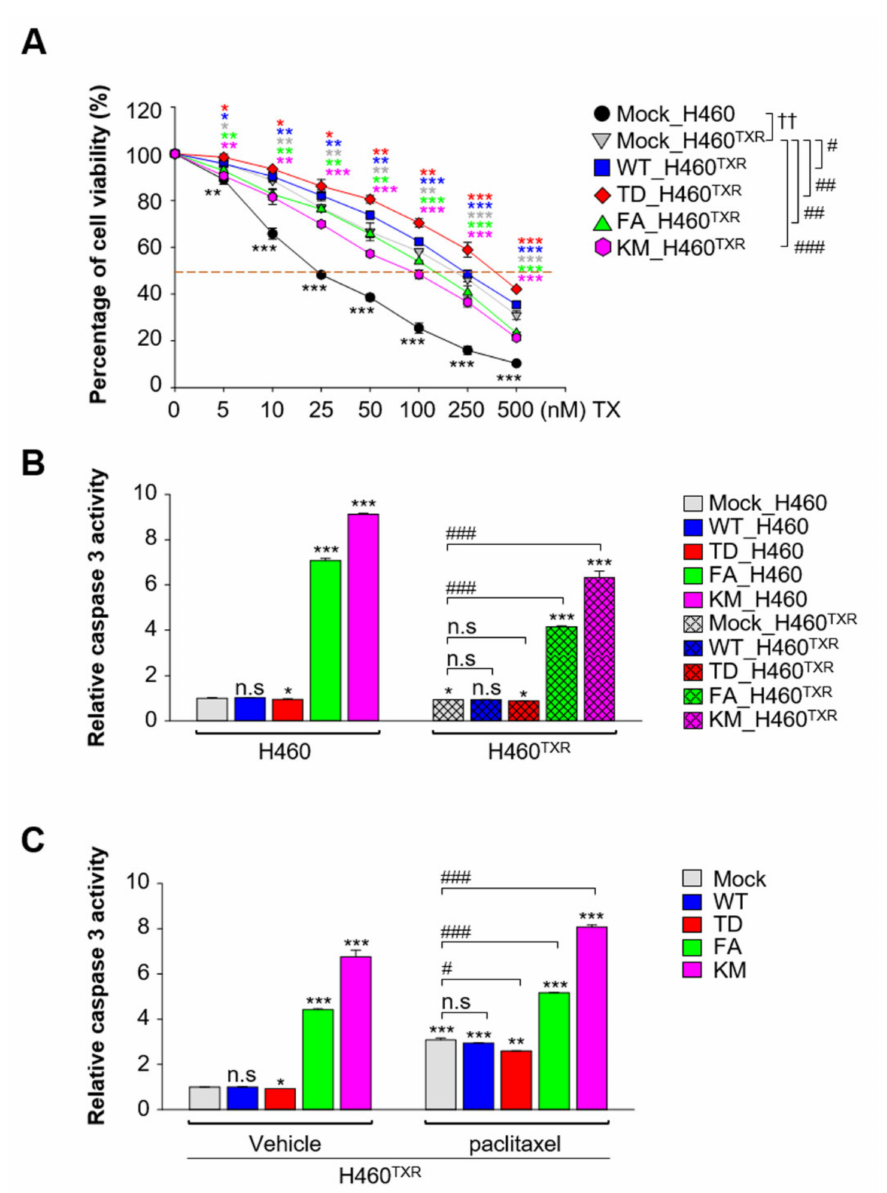
Figure 2. Paclitaxel-resistant NCI-H460 TXR lung cancer cells underwent apoptosis more easily